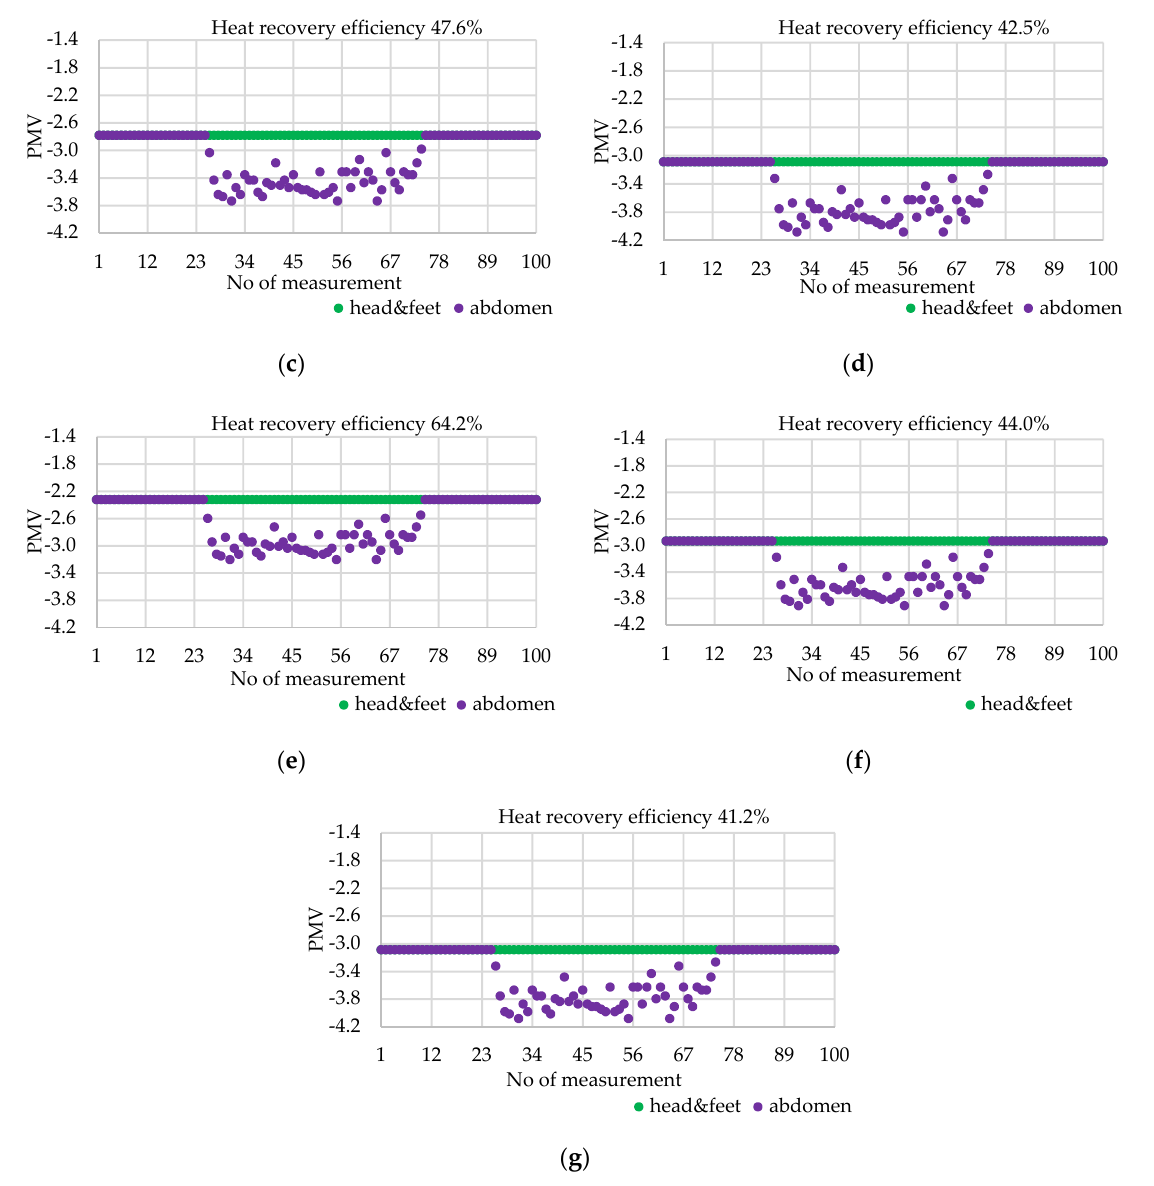
Figure 4. The course of the value of the PMV index for a 10-min cycle. Heat recovery exchanger: ( a ) ceramic, ( b ) jojoba oil, 10 mm, ( c ) jojoba oil, 25 mm, ( d ) jojoba oil, 40 mm, ( e ) coconut oil, 10 mm, ( f ) coconut oil, 25 mm, ( g ) coconut oil, 40 mm.